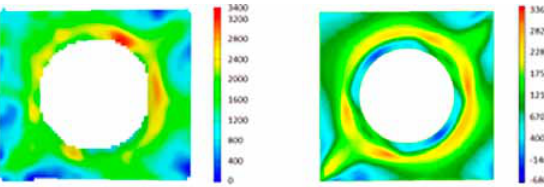
Fig. 9. Mises strain (beam 1C, side A, T = 9 000 N)